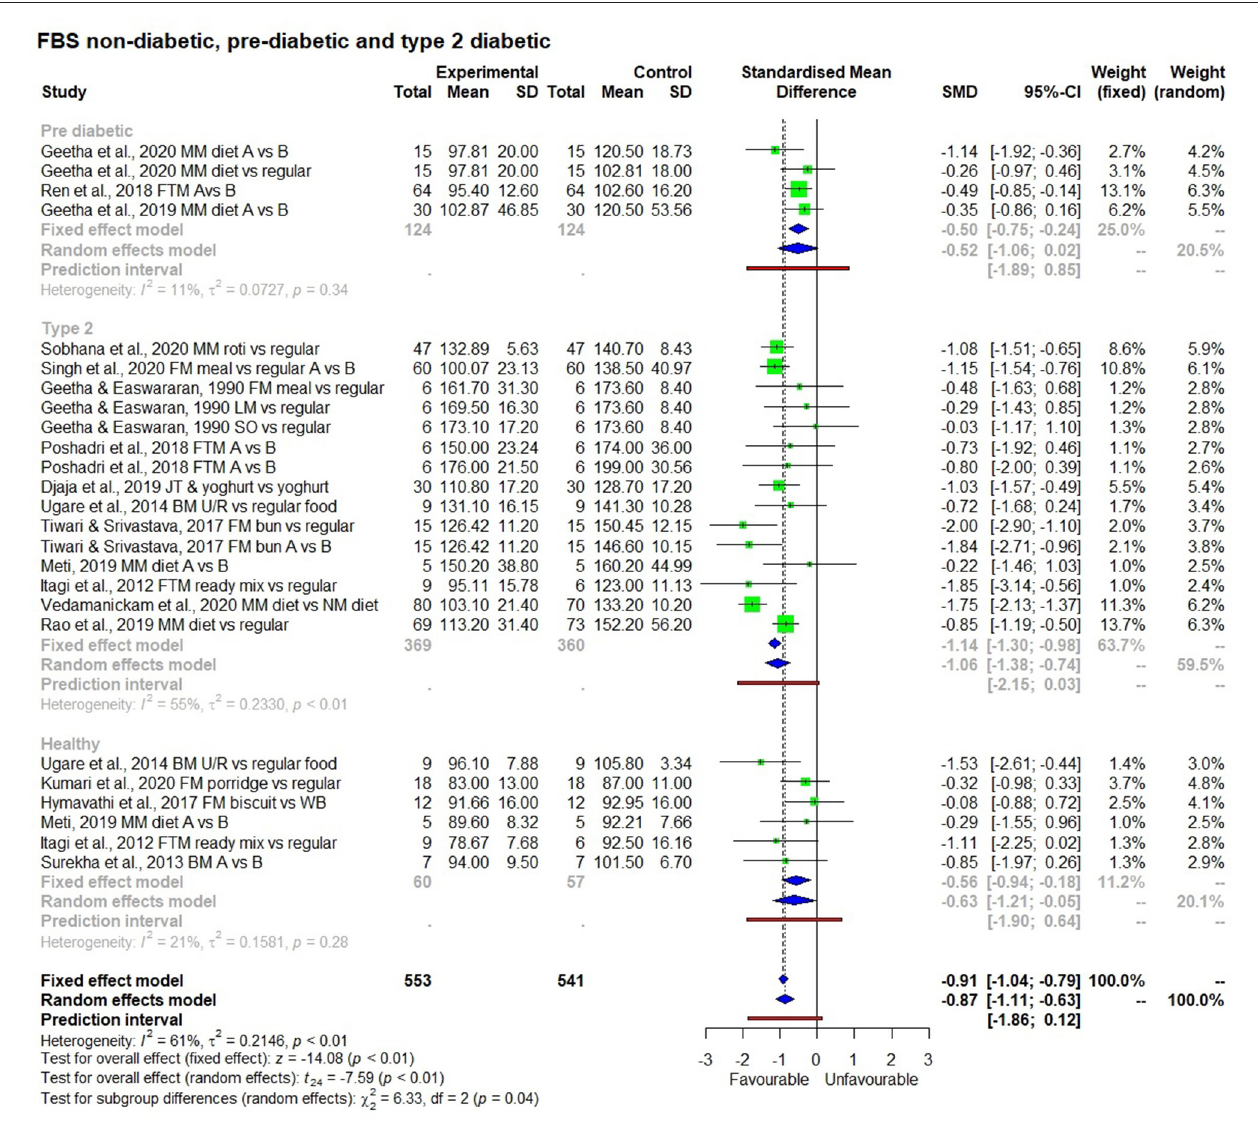
FIGURE 8 | The effect of long term consumption of millet on non-diabetic, pre-diabetic and diabetic subjects consuming millet compared to a control group consuming a regular diet.